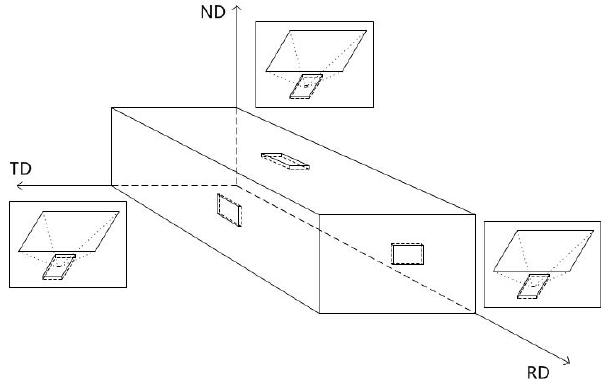
Figure 2. Schematic showing the sampling after hot rolling and annealing.